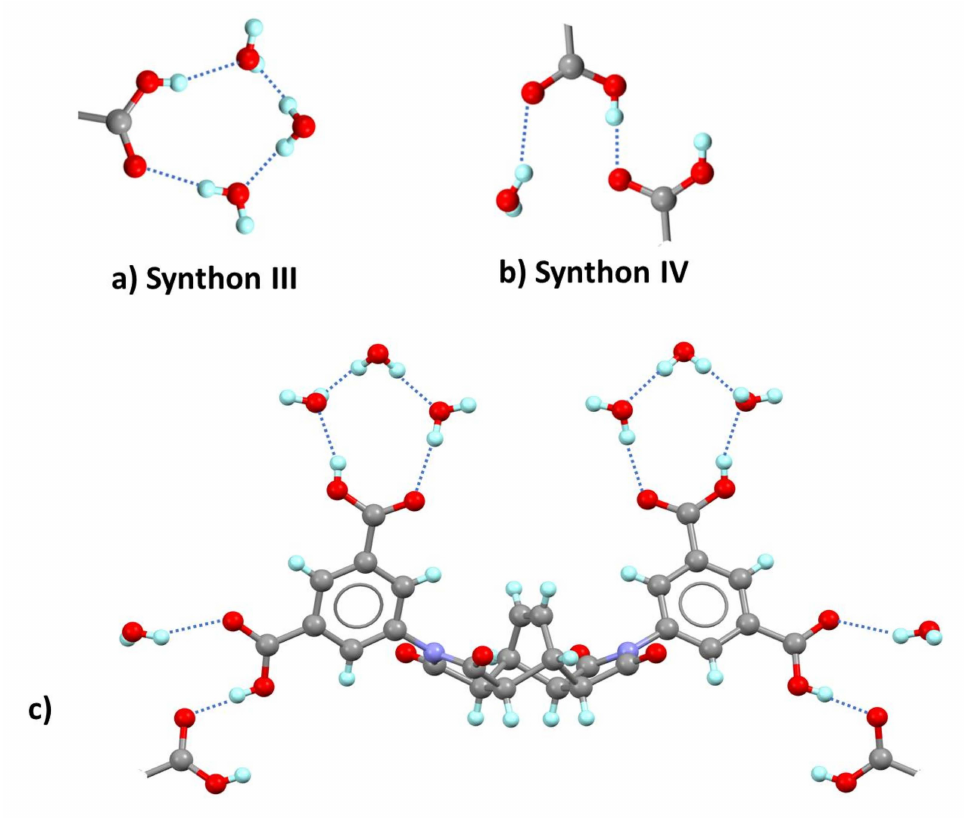
Figure 3. Two kinds of heterosynthons ( a , b ) and the H-bonds environment of one H 4 PTTA ( c ) in 1-H .